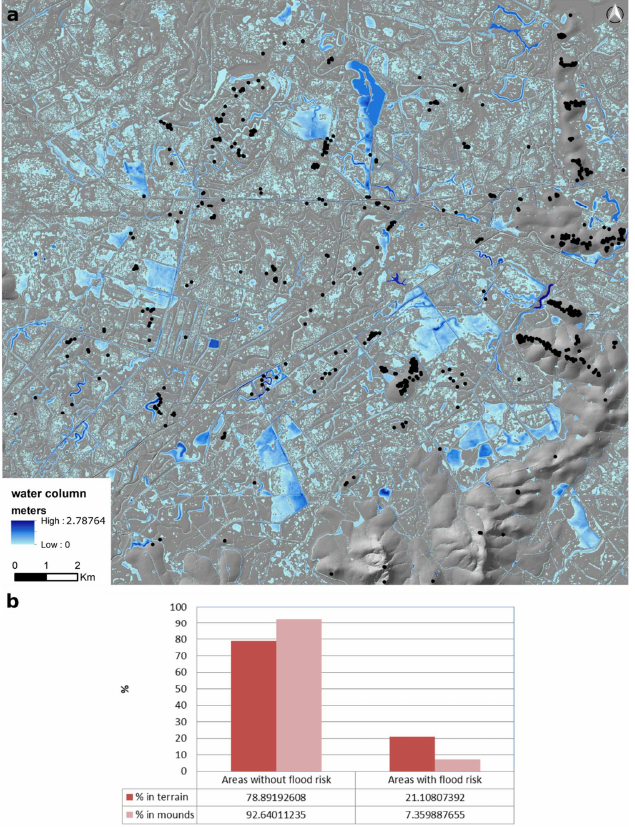
Figure 9. ( a ) Flood risk of the study area and location of the cerritos. The water column indicates the measurement, in meters, at which it would be possible to fill each point of the terrain until it over- flows into a catch basin. ( b ) Graph of the comparative flood risk between the zone with the cerritos and the general terrain. The prominence analysis takes a radius of 100 m as a reference for each point and the results show a clear trend of the prominence of the cerrito in this environment. If the ranges of prominence are distributed, more than 50% of the cerritos are in the maximum range of prominence, whereas only 10% of the random points are within this range. More than 65% of the mounds are more prominent than 80% of the random points. If the prom- inence of the cerritos is compared with the different radii of distance (variation of the size of the environment), the results show that as the radius increases (100, 200, 300, 1000 m), so does the prominence (Figure 10). The densest location of mounds in the Sierra de los